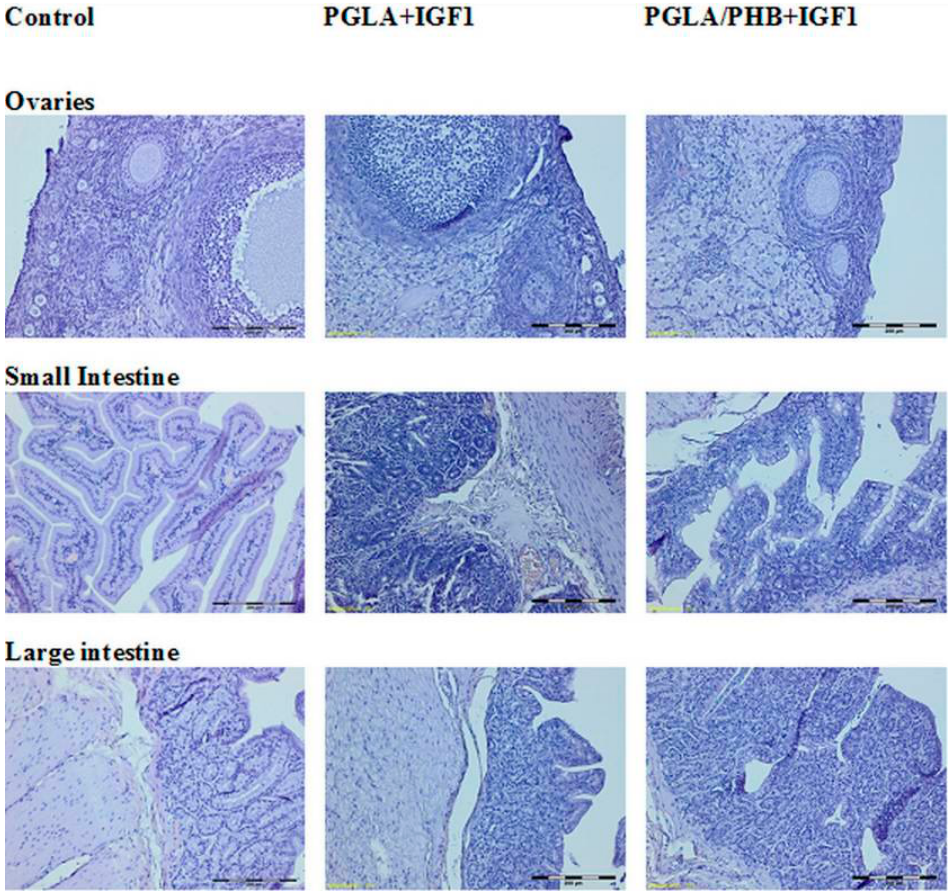
Figure 17. Microscopic images of internal organs (Dye HE. MG 100×).